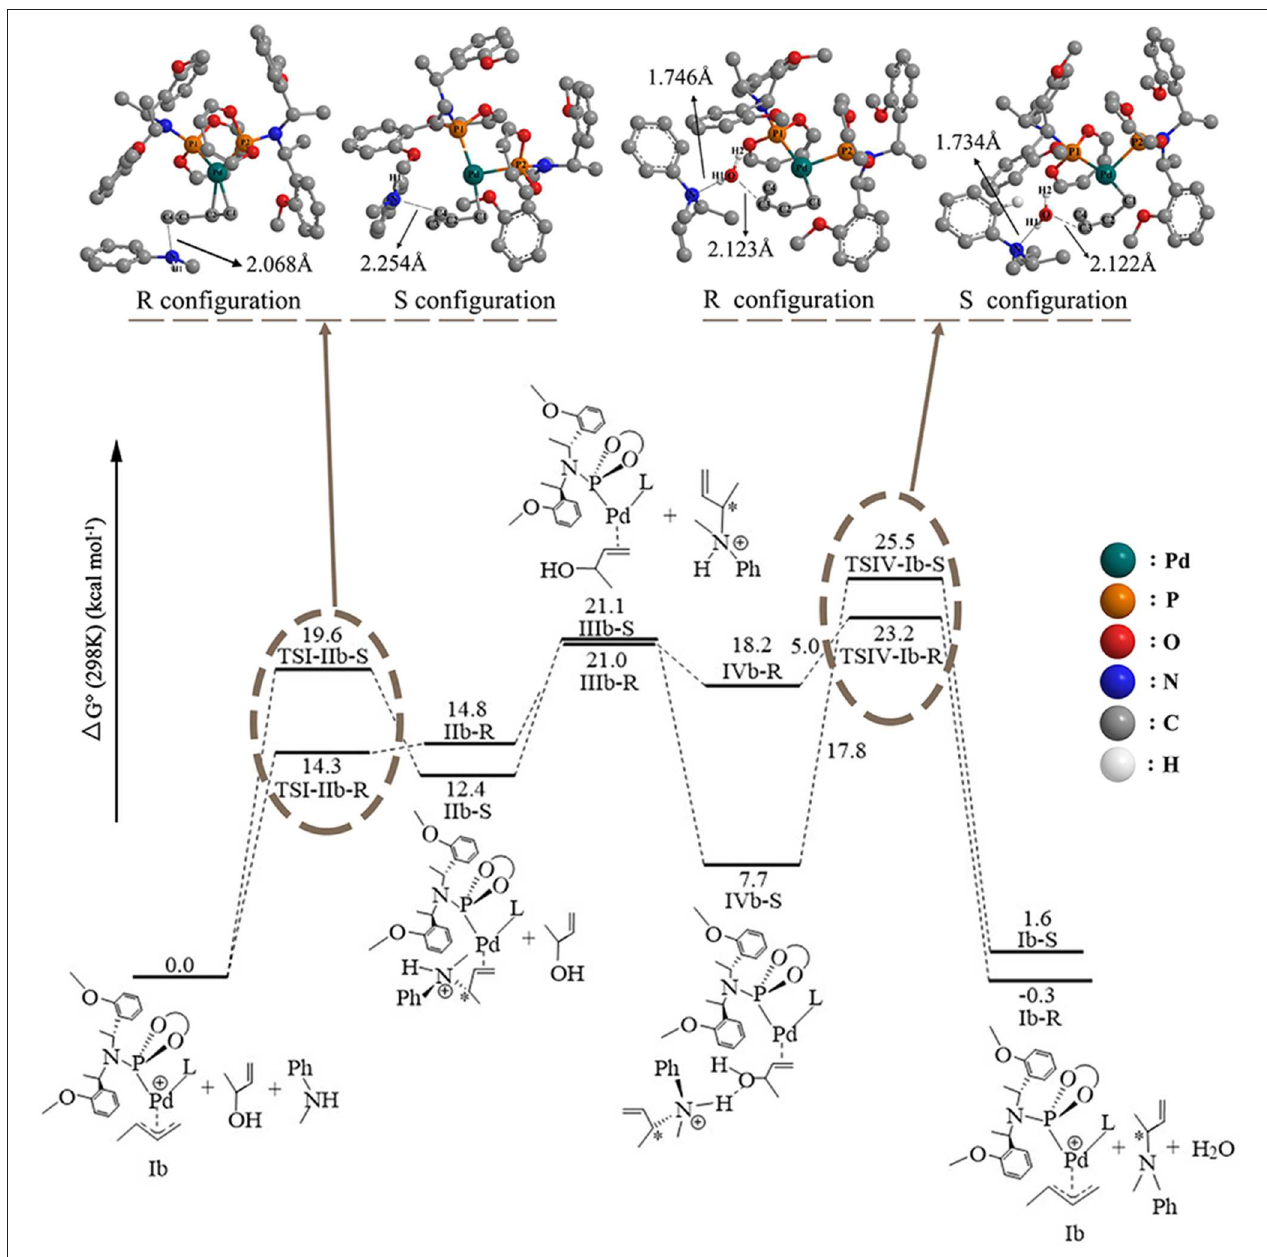
FIGURE 4 | The overall free energetic profiles for the 3-butene-2-ol amination reaction process in THF catalyzed by phosphoramidite Pd-L . The structure of the TSI-IIb-R/S and TSIV-Ib-R/S has been shown in ball-and-stick style; the important distance between atoms has also been shown in the corresponding place.